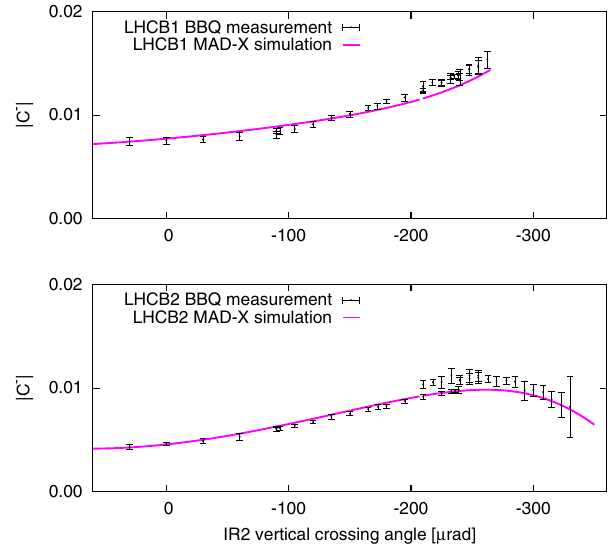
FIG. 6. Modeled and measured linear coupling of LHC beam 1 ¼ 1 m, plotted versus the total (top) and beam 2 (bottom) at β (cid:1) IP 2 vertical crossing angle of